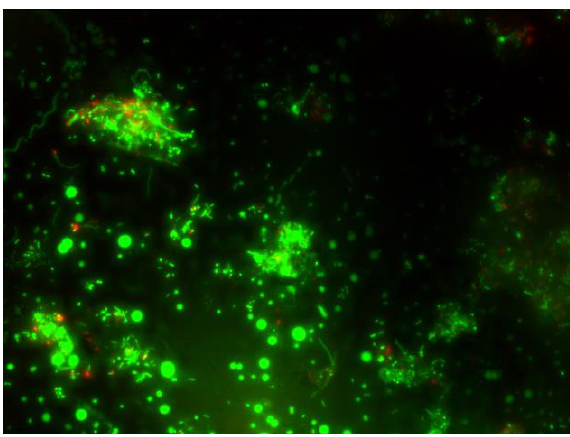
Fig. 7. The evaluation of live/dead bacteria, reference image before the ultrasound.